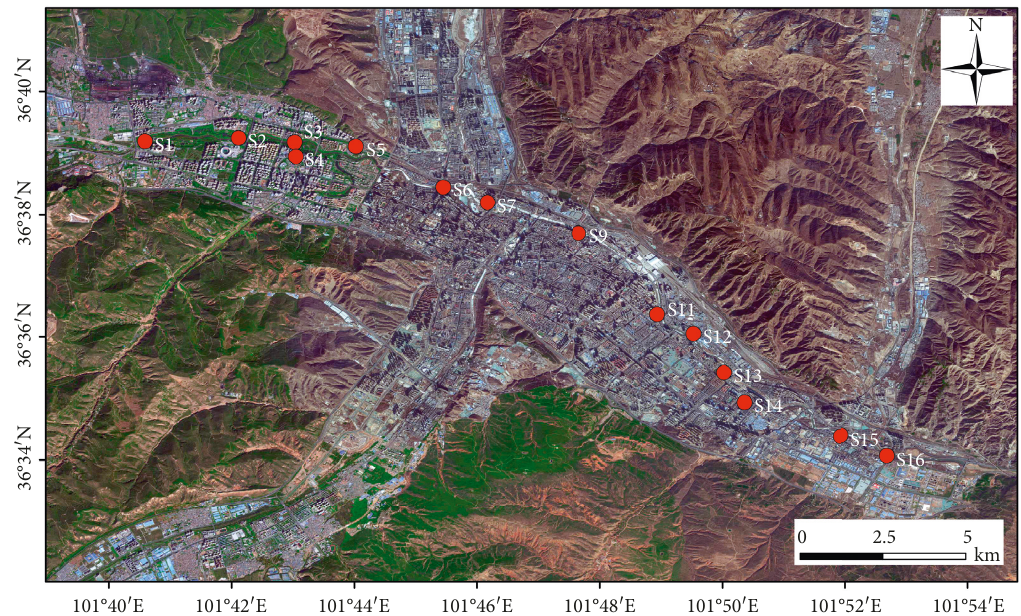
Figure 1: Sampling sites of Huangshui